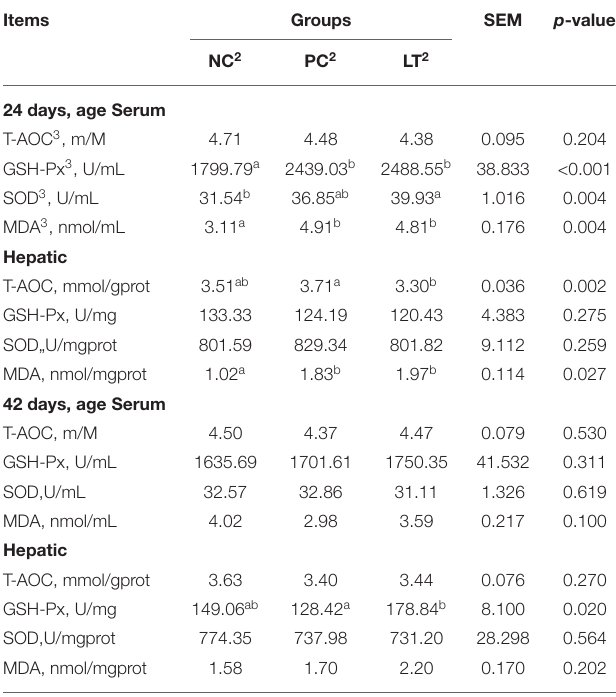
TABLE 6 | Effects of dietary L-theanine on antioxidant indices in the serumand hepatic of broilers under the oxidative stress 1 . Items Groups SEM p